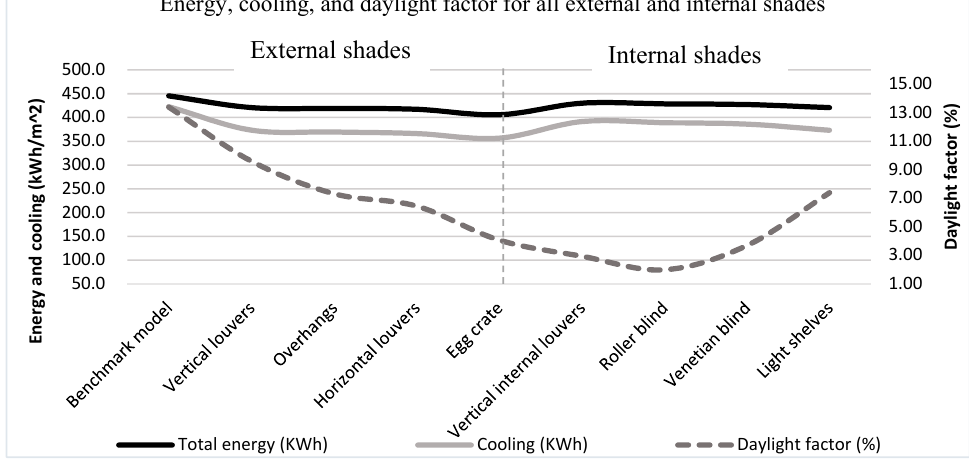
Figure 4. Outcomes of external and internal shade for energy consumption, cooling loads, and daylight factor.